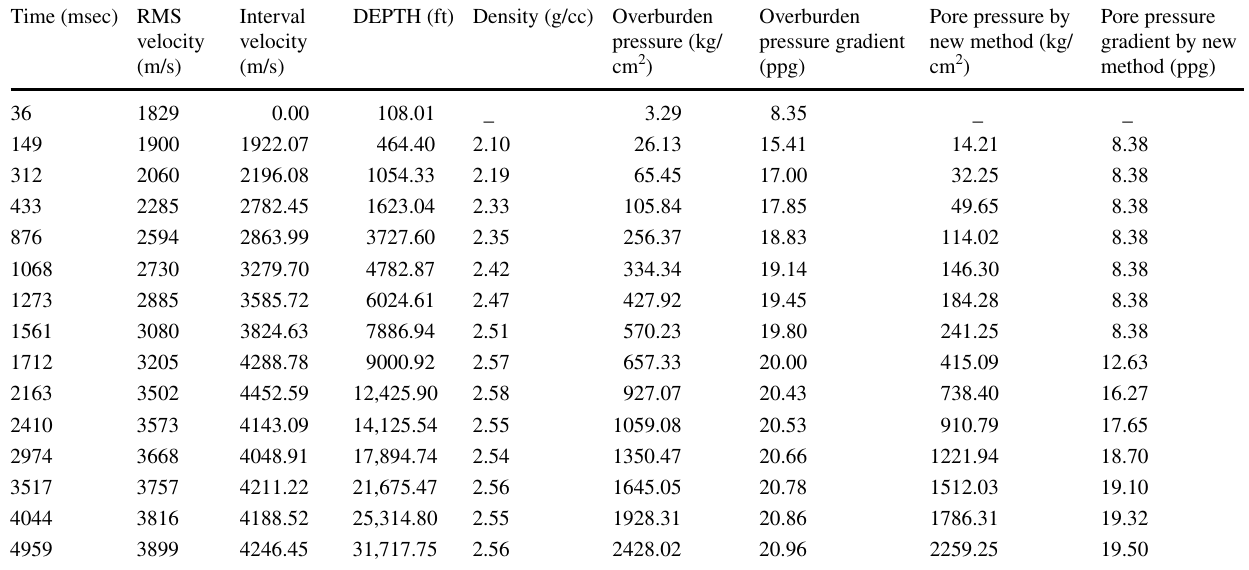
Table 2 Pore pressure prediction by a new method Time (msec) RMS